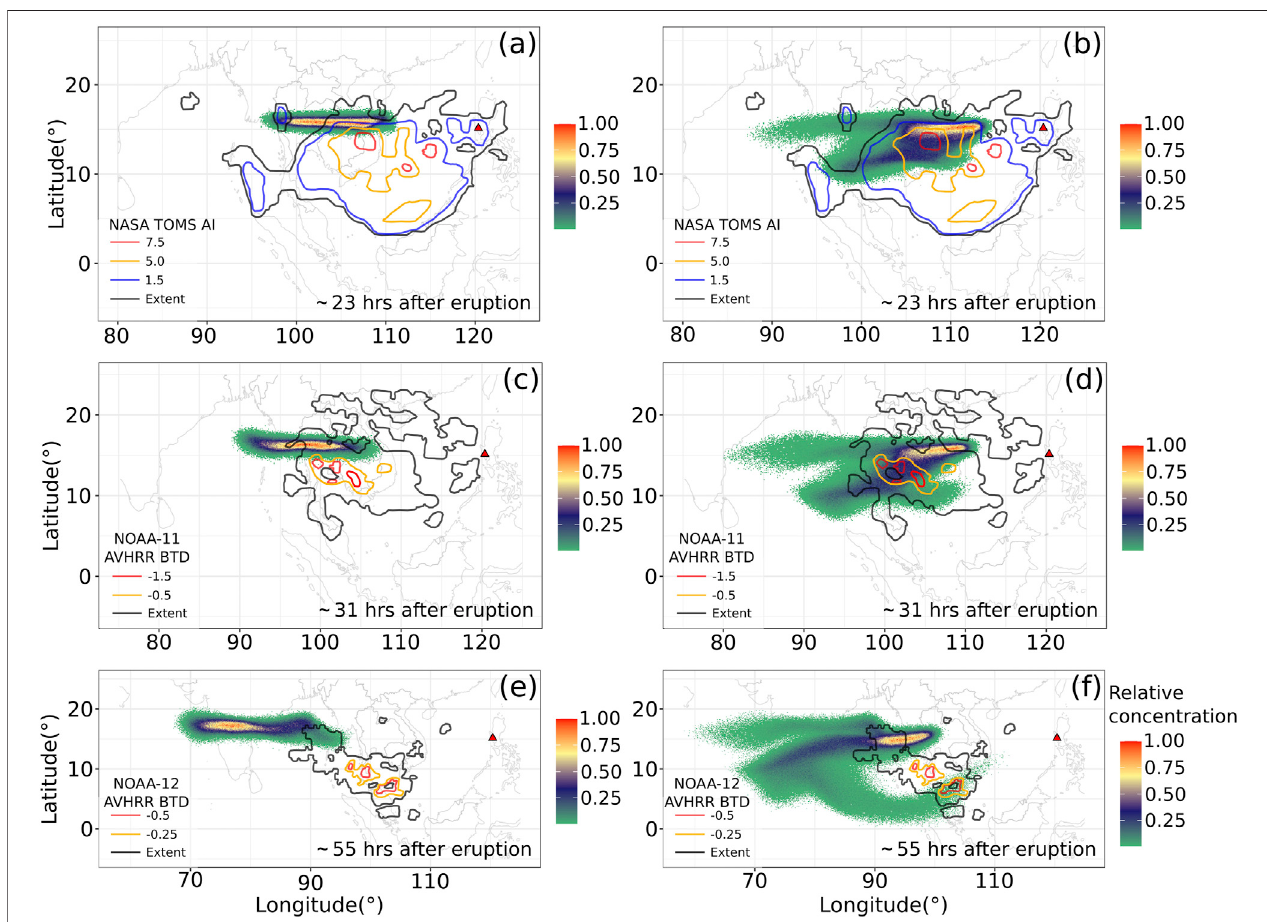
FIGURE 4 | Comparison between “ Semiempirical initial cloud + Puff ” and “ Plume-SPH + Puff ” . Pictures to the left, (A) , (C) and (E) , are Puff simulation based on initial condition created according to semiempirical plume shape expression. Pictures to the right, (B) , (D) and (F) , are Puff simulation based on initial conditions generated by Plume-SPH. TOMS or AVHRR images of Pinatubo ash cloud are overlapped with the simulation results. Ash clouds at different hours after eruption are on different rows. From top to bottom, the images correspond to around 23 h after eruption (UT 199106160341), 31 h after eruption (UT 199106161141), 55 h after eruption(UT199106171141).Theobservationdataonthe fi rstrowareTOMSAI(aerosolindex)map.TheobservationdataonthesecondandthirdrowareAVHRRBTD (brightness temperature difference) ash cloud map with atmospheric correction method applied (Guo et al., 2004b). The contours of simulation results are maximum concentrationatgiven( longitude , latitude ).Thecoloreddotsaresimulationresultsofrelativeconcentrationswhosevaluesarebetweenzerotooneandhavenounit,and the solid contours are observed in Dobson Units.